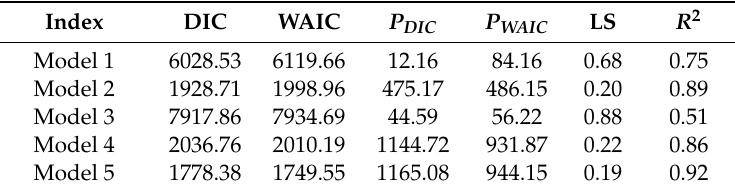
Table 2. Evaluations for the five alternative regressions considering model fitness, complexity, predictive power, and explained